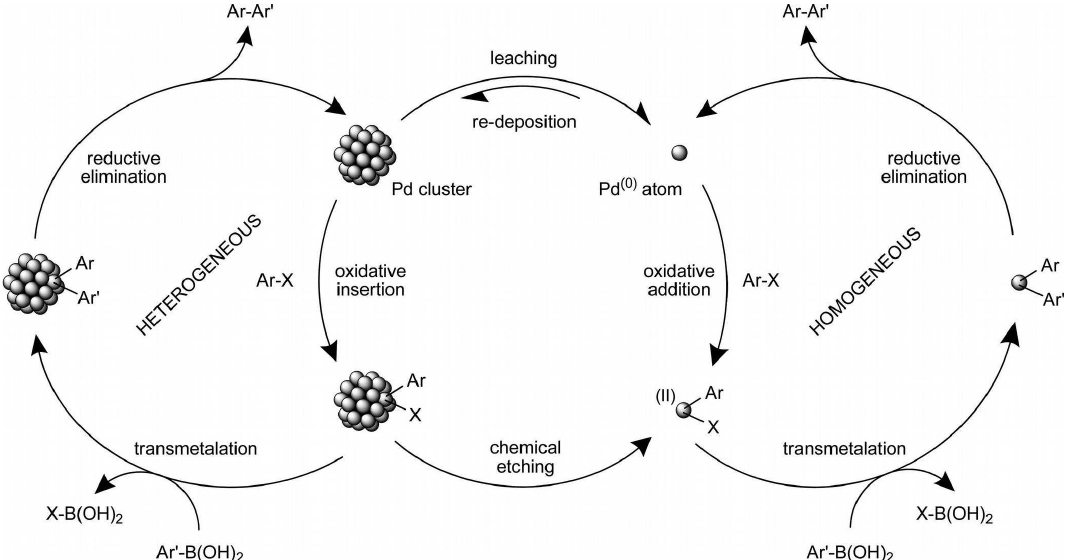
Figure 1. Proposed mechanism for the PdNP-catalyzed Suzuki cross-coupling involving both homogeneous and "heterogeneous" pathway, reprinted with permission from [14]. Copyright (2012) American Chemical Society. Please note that both act in the liquid phase.